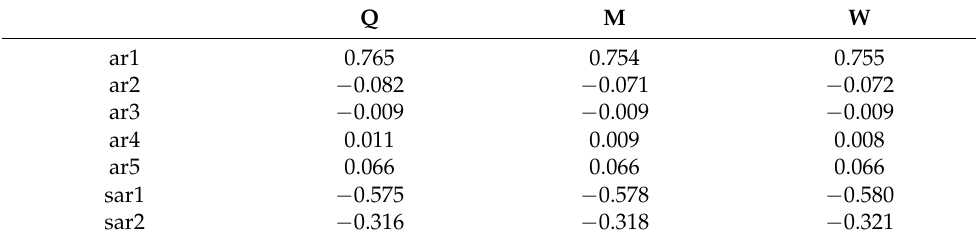
Table 3. Estimated structural parameters of the SARIMA models.